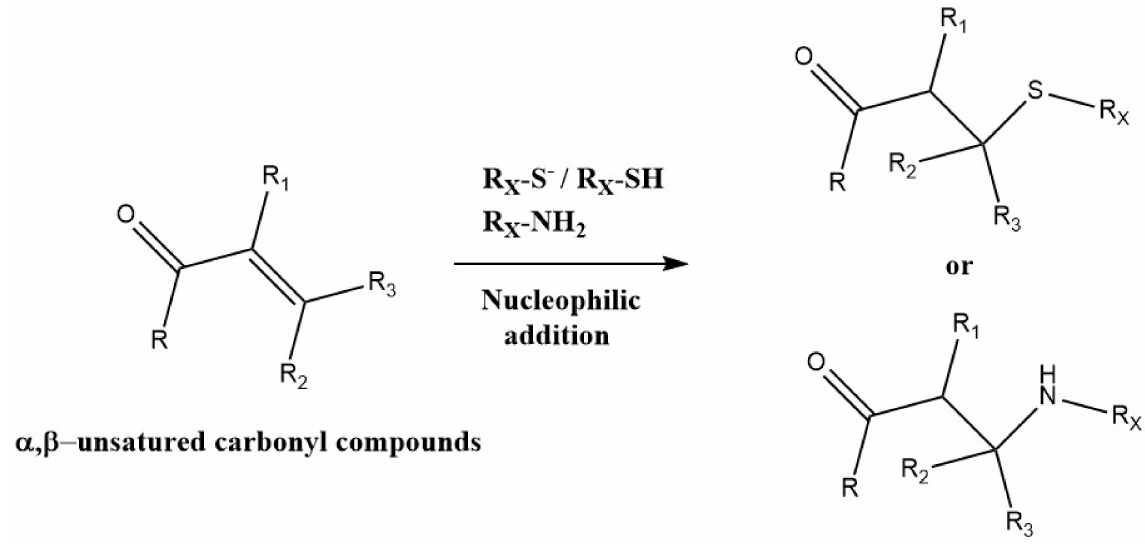
Figure 4. Michael addition reactions of nucleophiles to αβ -unsaturated carbonyl